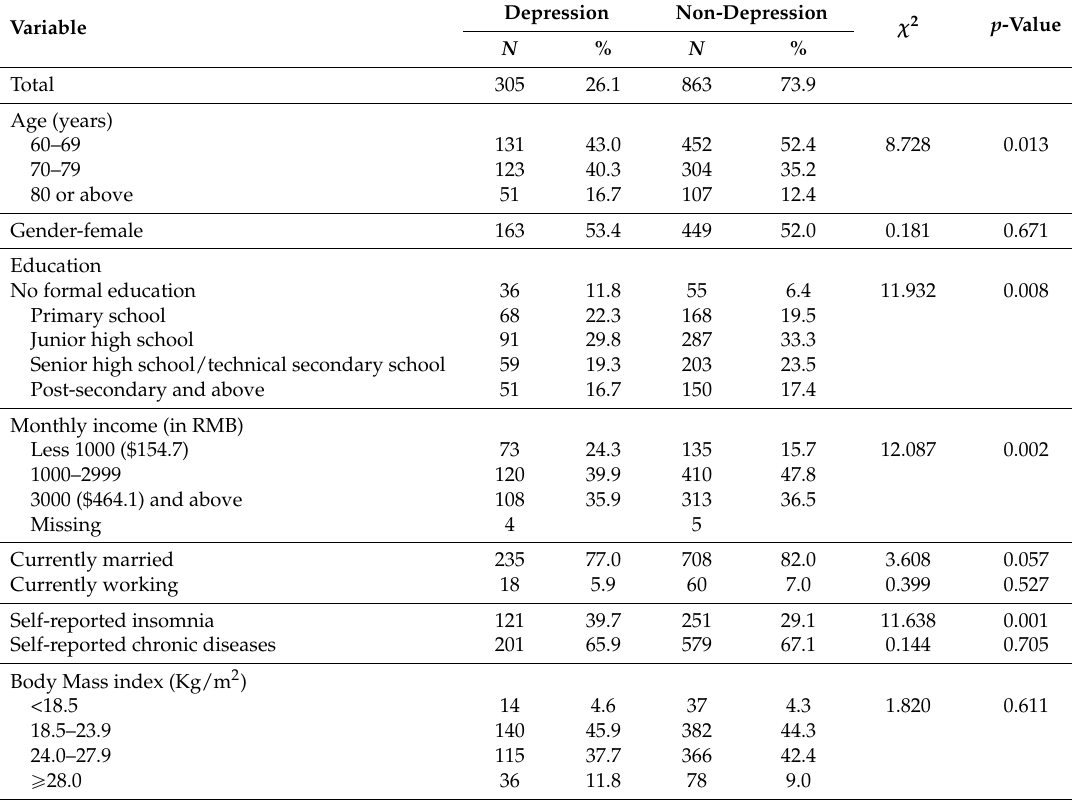
Table 2. Demographic variables related to depression among older people ( n = 1168).